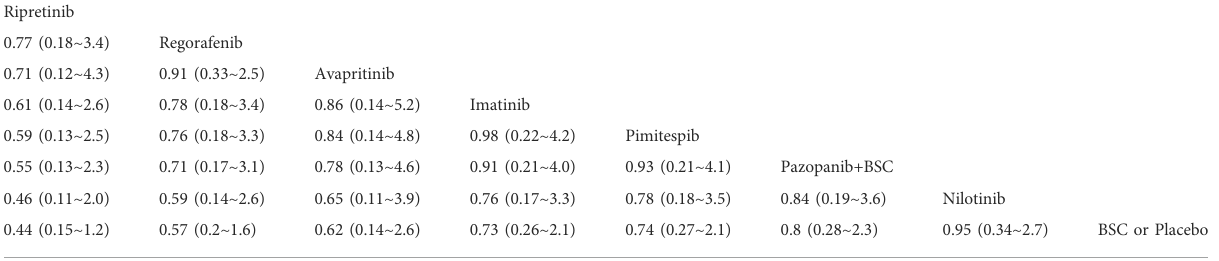
TABLE 3 Results of the network meta-analysis for